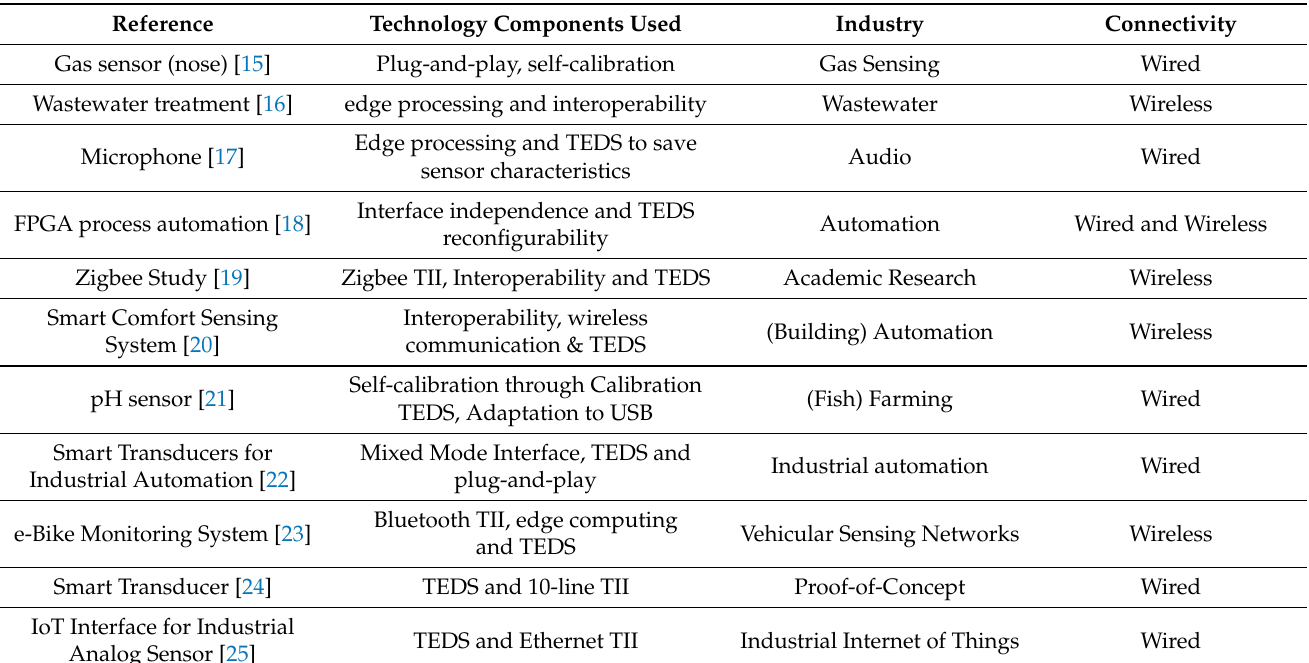
Table 1. Summary on the usage of IEEE